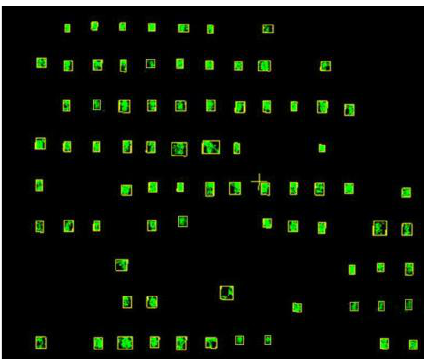
Figure 9. Clustering effect after semantic